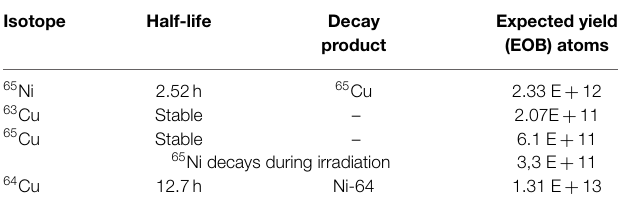
TABLE 4 | Direct and indirect productions of stable copper isotopes with a deuteron beam on Ni-64